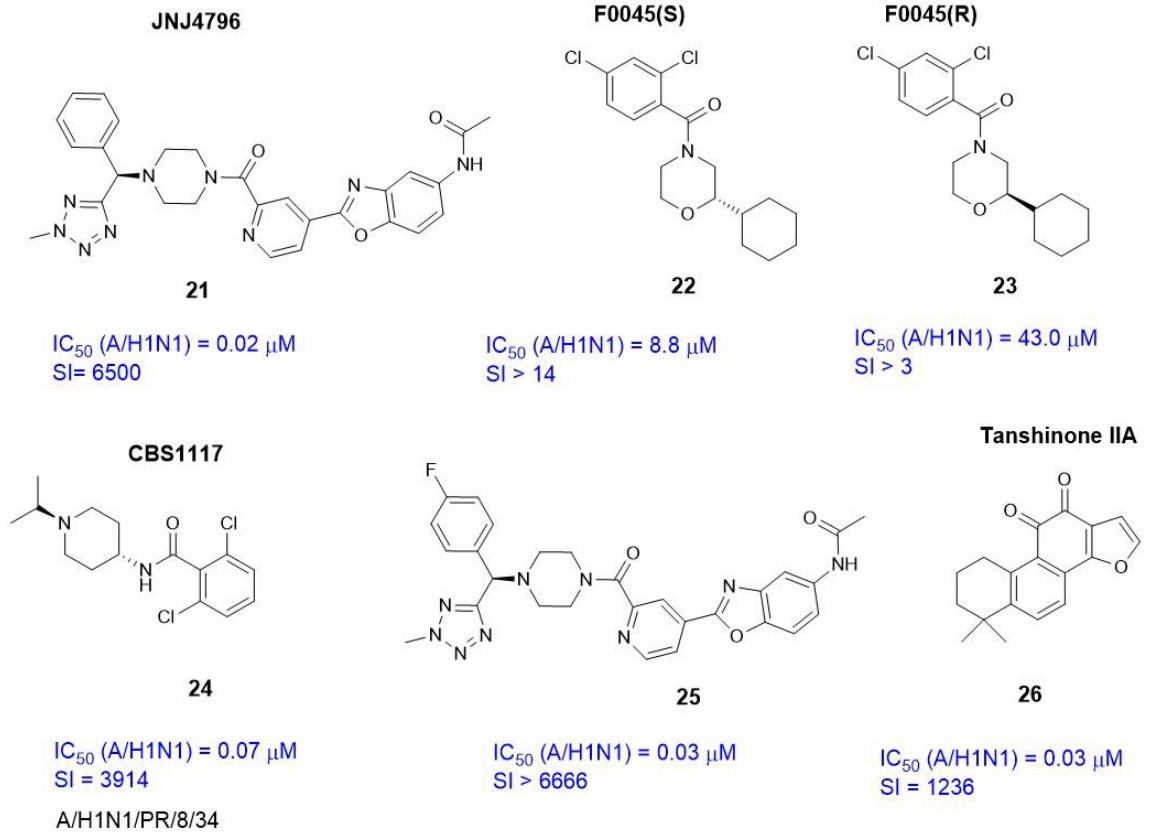
Figure 8. Inhibitors of HA binding in the HA epitopes. An epitope recognized by the small molecule 21 was similar to the epitopes associated with bnAb, namely CR6261, FI6v3, and CR9114. In other words, agent 21 binds in a hydrophobic pocket on the outer surface of HA (H1) and mimics CR6261-like intermolecular interactions with amino acids: H 1 18, H 1 38, L 1 42, T 1 318, G 2 20, W 2 21, T 2 41, and L 2 56. Thus, the mechanism of antiviral action of 21 is to inhibit pH-sensitive conformational rearrangements that are triggered by the fusion of viral and cell membranes. The compound exhibits antiviral activity against influenza A virus strains at nanomolar concentrations (Figure